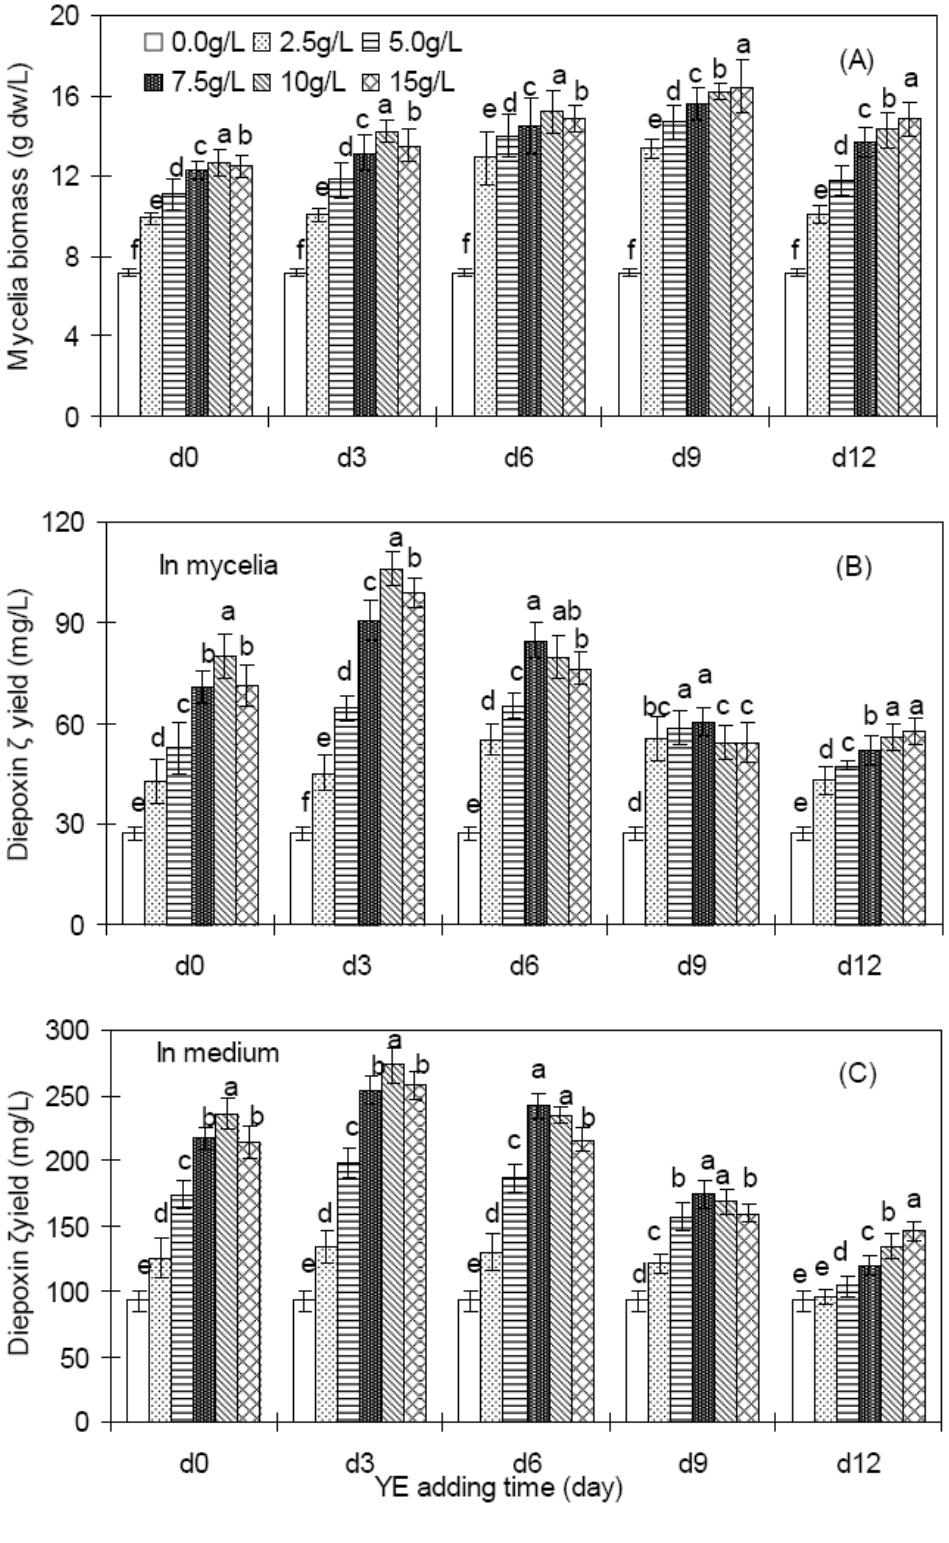
Figure 2. Effects of YE (0 to 15 g/L) on mycelia growth (A), intracellular diepoxin ζ production (B), and extracellular diepoxin ζ production (C) in liquid culture of endophytic fungus Dzf12. The period of culture was 13 days; The error bars represented standard deviations, n = 3; Different letters ( i.e ., a-f) indicated significant differences among the treatments in each YE adding time at p = 0.05